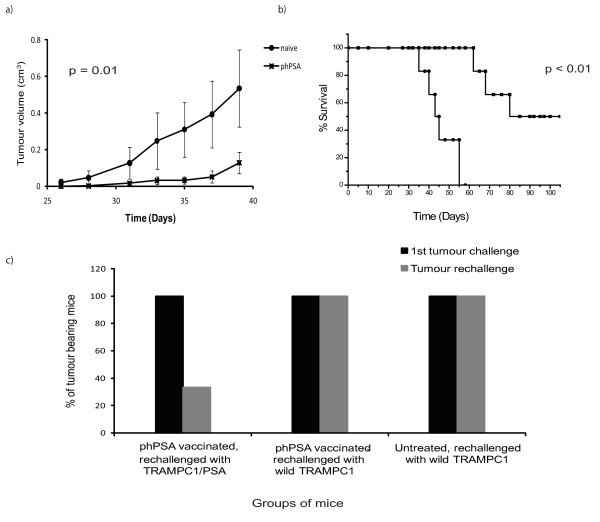
In vivo adoptive transfer of lymphocytes and antigen specific response. a) Low tumour volumes were observed in mice (n = 6) receiving splenocytes from immunised group and this slow growth of the tumours provided a prolonged survival. b). Data are expressed as means ± SEM. c) Antigen specific responses - groups of mice (n = 6) were immunised (regimen 3) and challenged s.c. (1st tumour challenge) either with wild TRAMPC1 or transfected TRAMPC1 (TRAMPC1/hPSA). After surgical excision of the tumours and 30 days period of observation, mice were rechallenged (Tumour rechallenge), either with wild type TRAMPC1 or TRAMPC1/hPSA cells. The vaccine response was antigen specific, as on re-challenge tumour protection was only observed in mice with neo-adjuvant immunisation and rechallenge with TRAMPC1/hPSA. Only 33% mice developed tumour after rechallenge, while remaining mice remained tumour free for more than 100 days post rechallenge with TRAMPC1/hPSA.